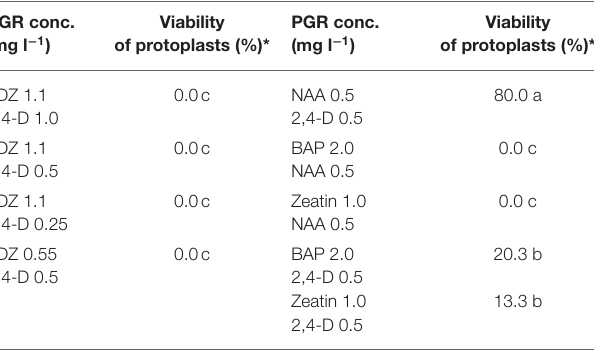
TABLE 1 | Effect of PGRs in MI medium on protoplast growth and development of rapeseed.